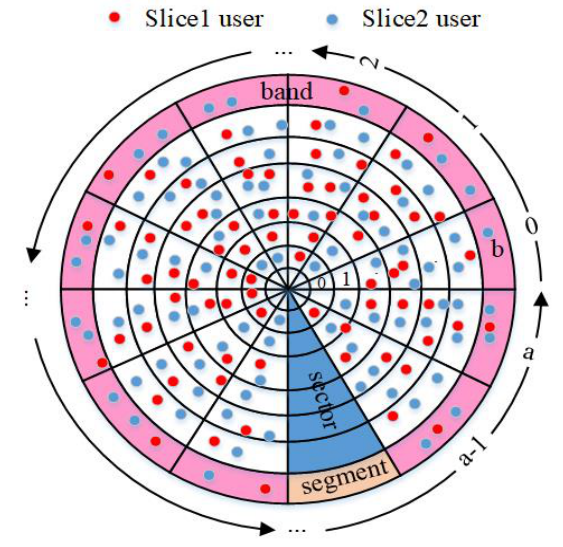
Figure 1. Schematic of slice user